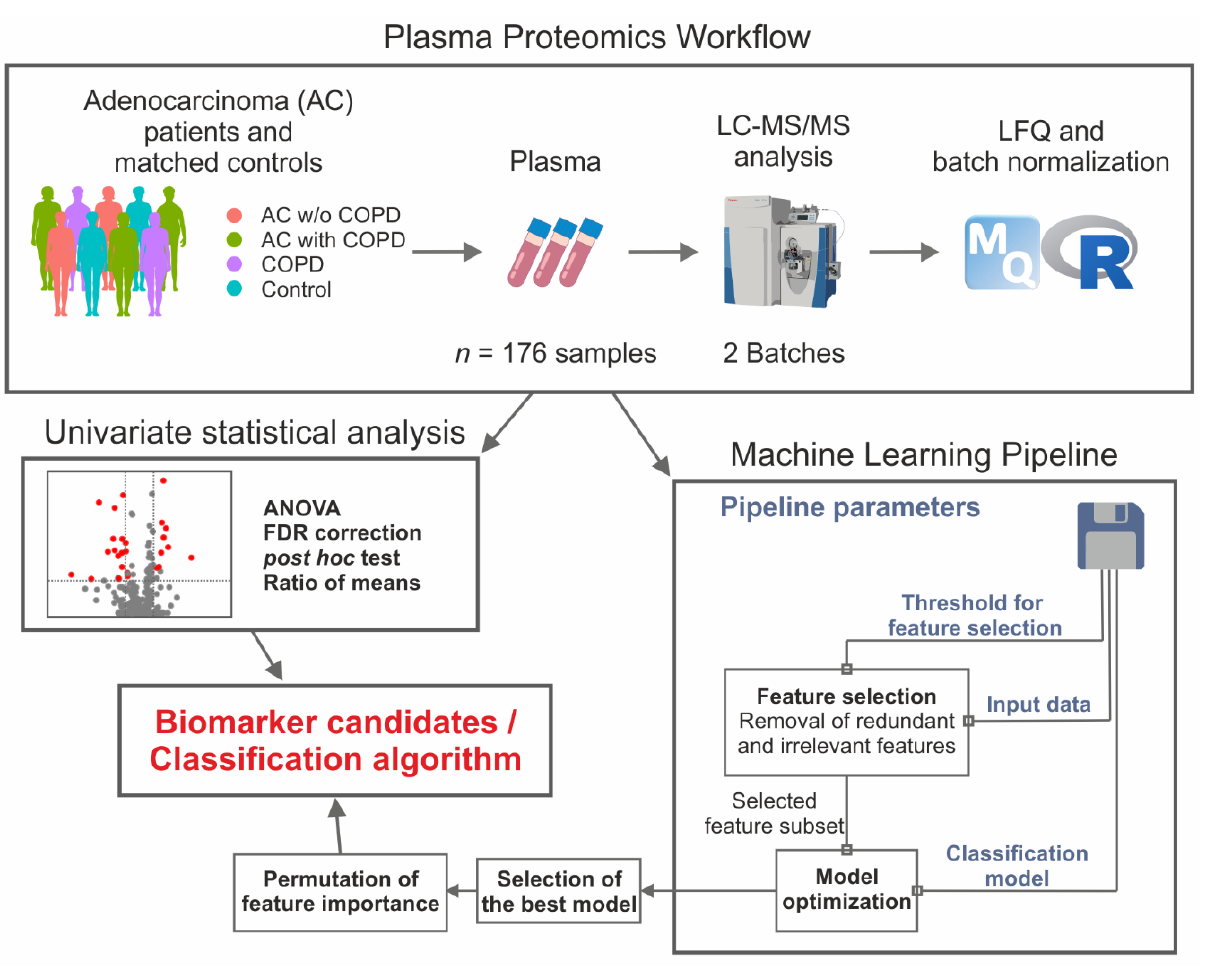
Figure 1. Schematic representation of the project workflow. Plasma samples from n = 176 patients were analyzed in two batches using LC – MS/MS. Proteins were quantified label-free and the resulting intensities were normalized to account for batch effects. Normalized intensities were analyzed by univariate statistics and machine learning approaches. Five different machine learning algorithms were compared using the same modeling pipeline.